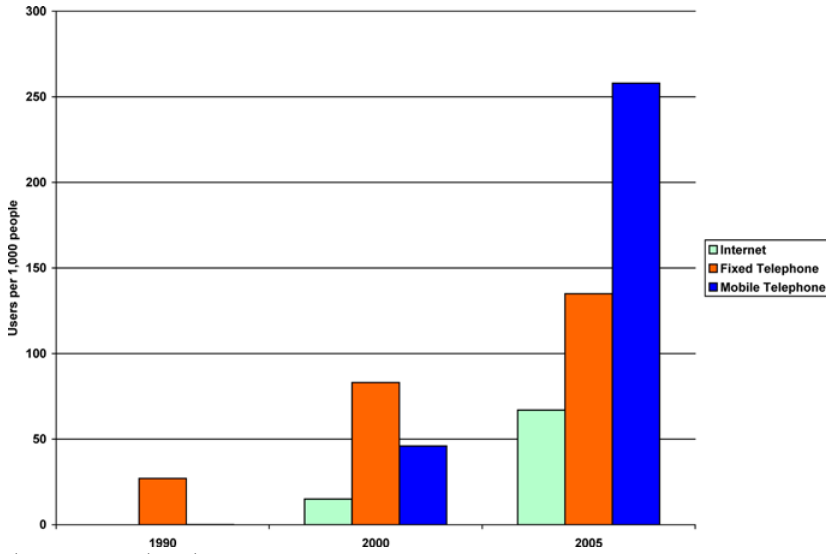
Figure 1. Internet and Telephone Access in Developing Countries Adapted from [22].